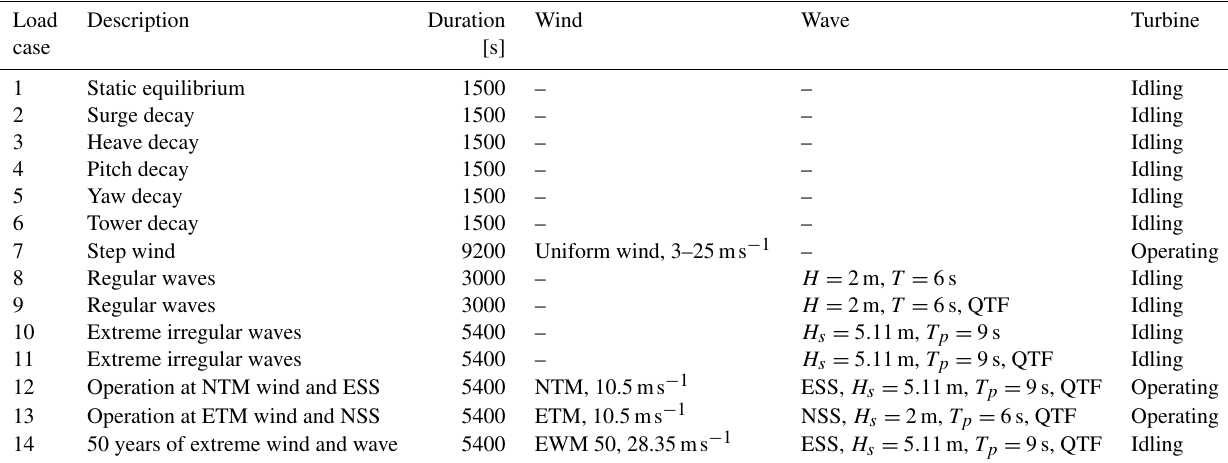
Table 8. Load cases used in OpenFAST for the assessment of the models.